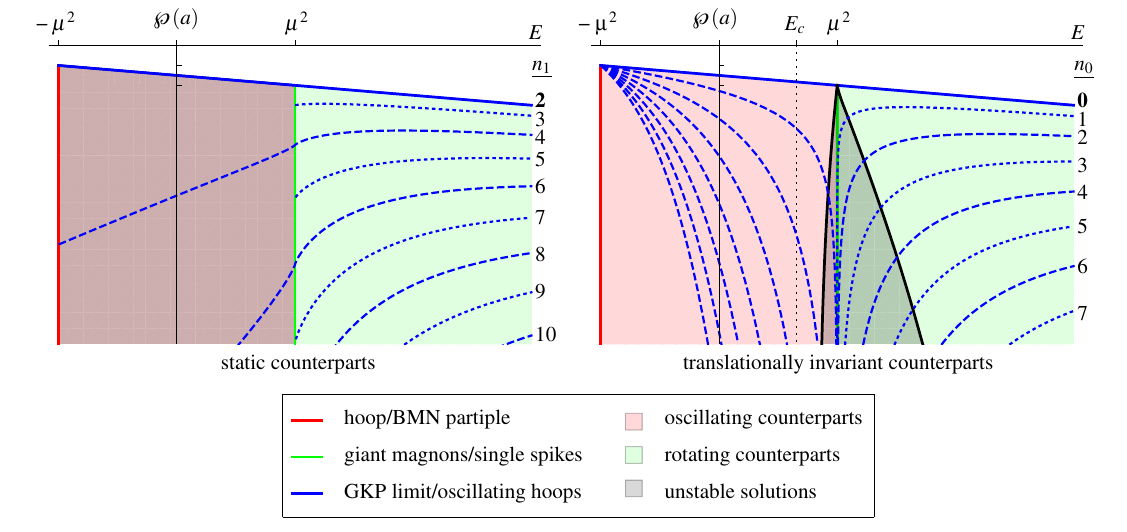
strapretnuoctnairavniyllanoitalsnartstrapretnuoccitats